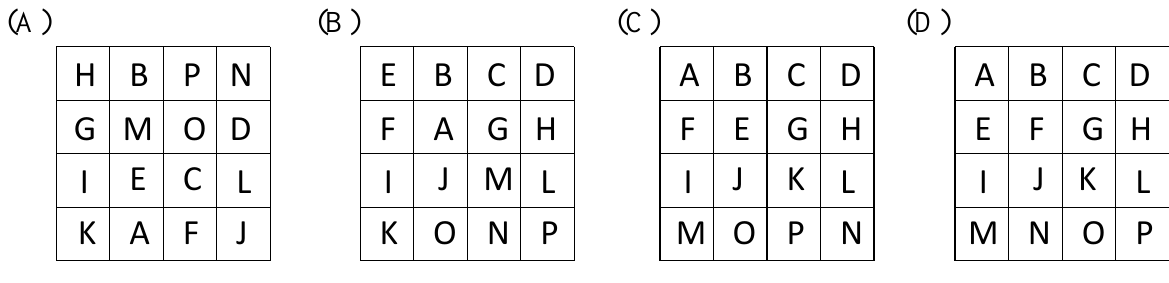
Fig. 1. A 4 × 4 square tile puzzle with 16 different letters. The goal is to list the letters in order of the alphabet. Each letter is assigned a different integer value, and the resulting inverse problem is solved using DREAM ( D ) . The left panel (a) presents the initial state, whereas the remaining three graphs (b–d) demonstrate how DREAM ( D ) iteratively solves this integer sampling problem.